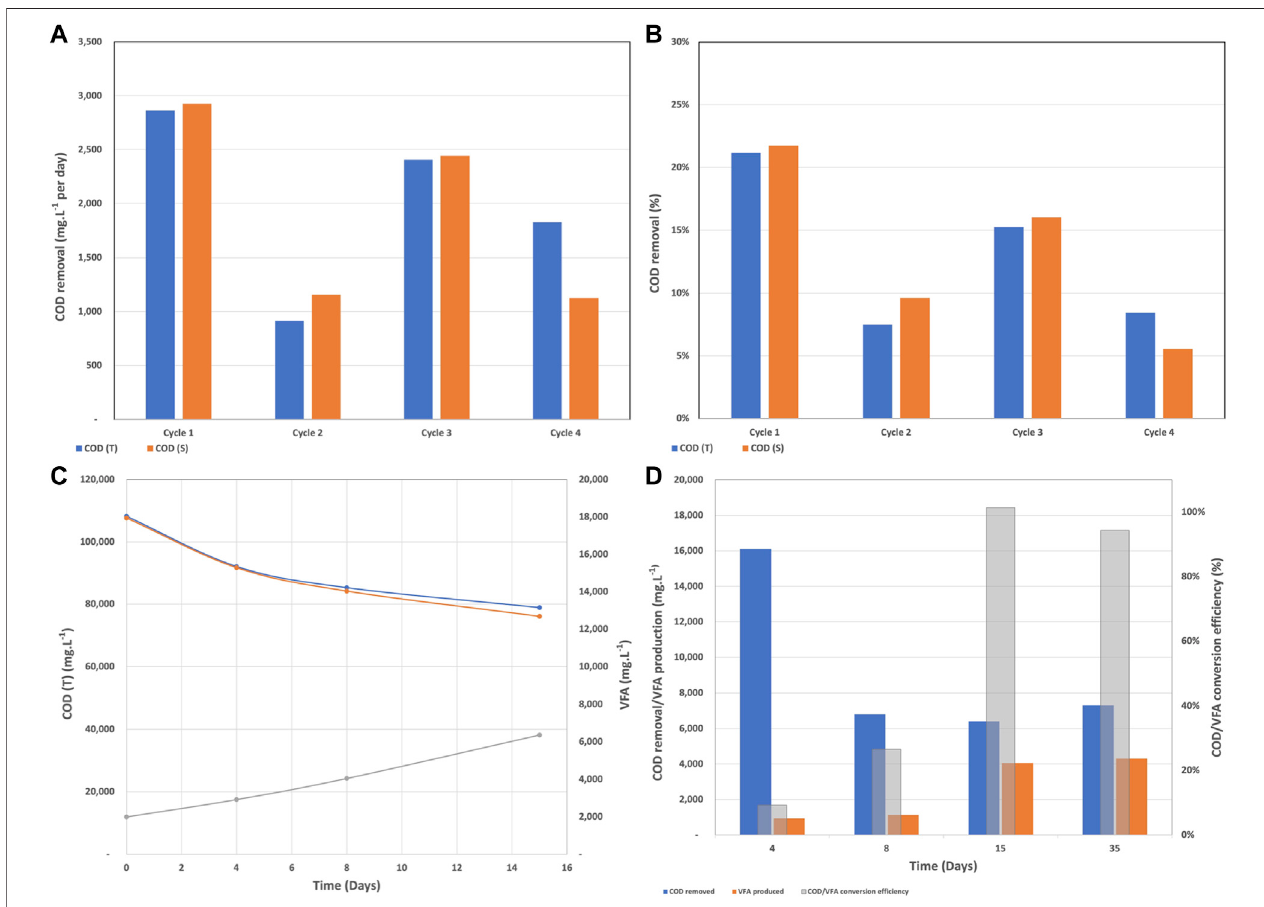
FIGURE 2 | (A) COD removal rate in mg/L per day, (B) COD removal rate in percentage, (C) COD and VFA trends over the fi rst 15 days, and (D) COD to VFA conversion ef fi ciency and removal during batch